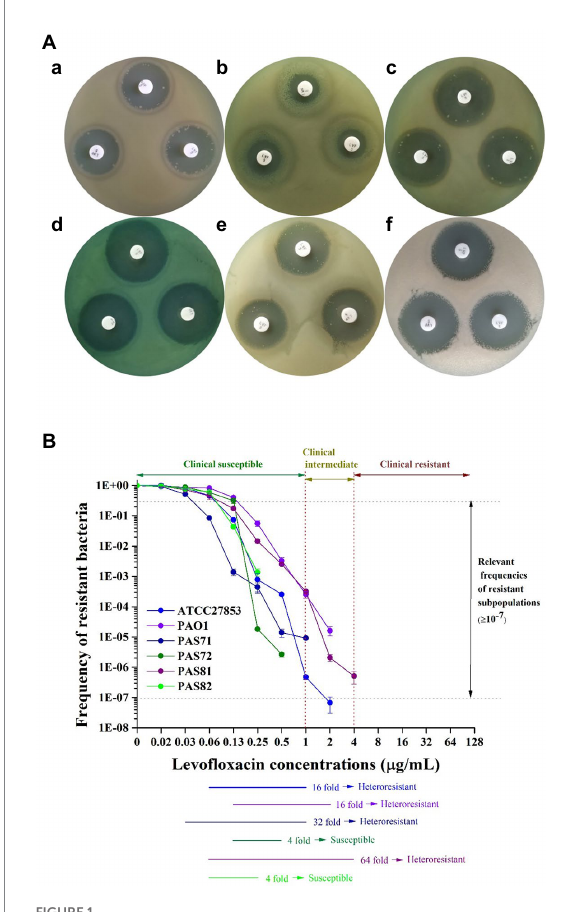
FIGURE 1 Photos and curves of heteroresistance characteristics of six Pseudomonas aeruginosa strains to LVX. (A) Kirby–Bauer (K–B) test. a, P. aeruginosa ATCC27853, heteroresistant to LVX; b, P. aeruginosa PAO1, heteroresistant to LVX; c, P. aeruginosa PAS71, heteroresistant to LVX; d, P. aeruginosa PAS72, susceptible to LVX; e, P. aeruginosa PAS81, heteroresistant to LVX; f, P. aeruginosa PAS82, susceptible to LVX. (B) Schematic population analysis profile (PAP) curves. The clinical susceptible, intermediate, and resistant levels of P. aeruginosa to LVX are indicated by two red vertical dotted lines. The area between the two horizontal gray dotted lines suggest that the resistance frequencies of the subpopulations are ≥ 1 × 10 − 7 . Six horizontal-colored lines highlighted the PAP test results of the six P. aeruginosa strains from the maximum concentration that did not inhibit growth of the main subpopulations to the end of the concentration when the resistance frequency of the subpopulations was ≥ 1 × 10 − 7